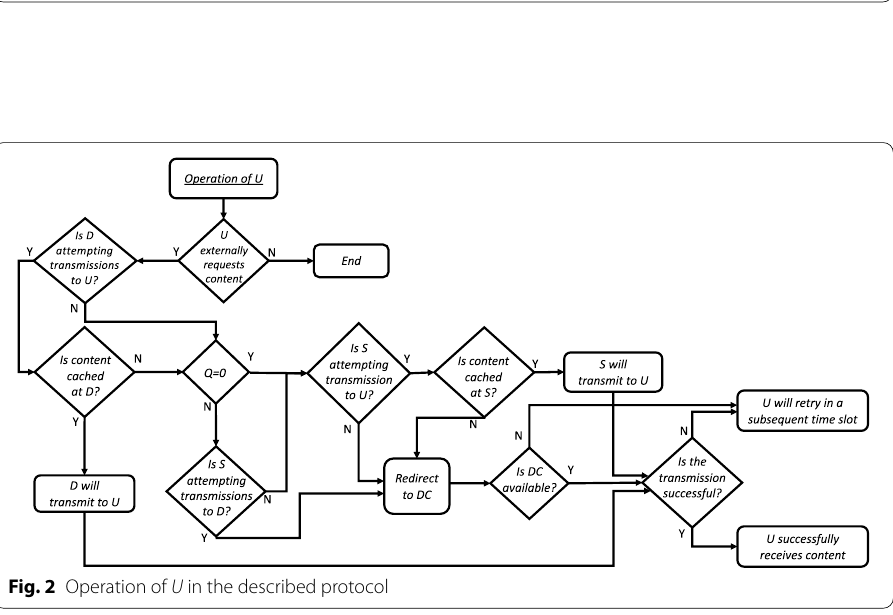
Fig. 2 Operation of U in the described protocol